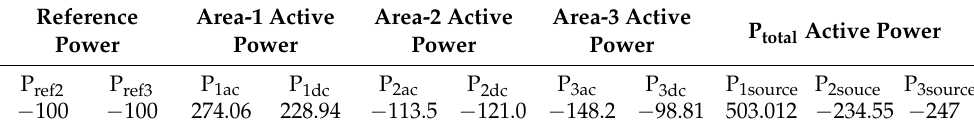
Table 3. Active power flow at all areas, (power is given in MW).